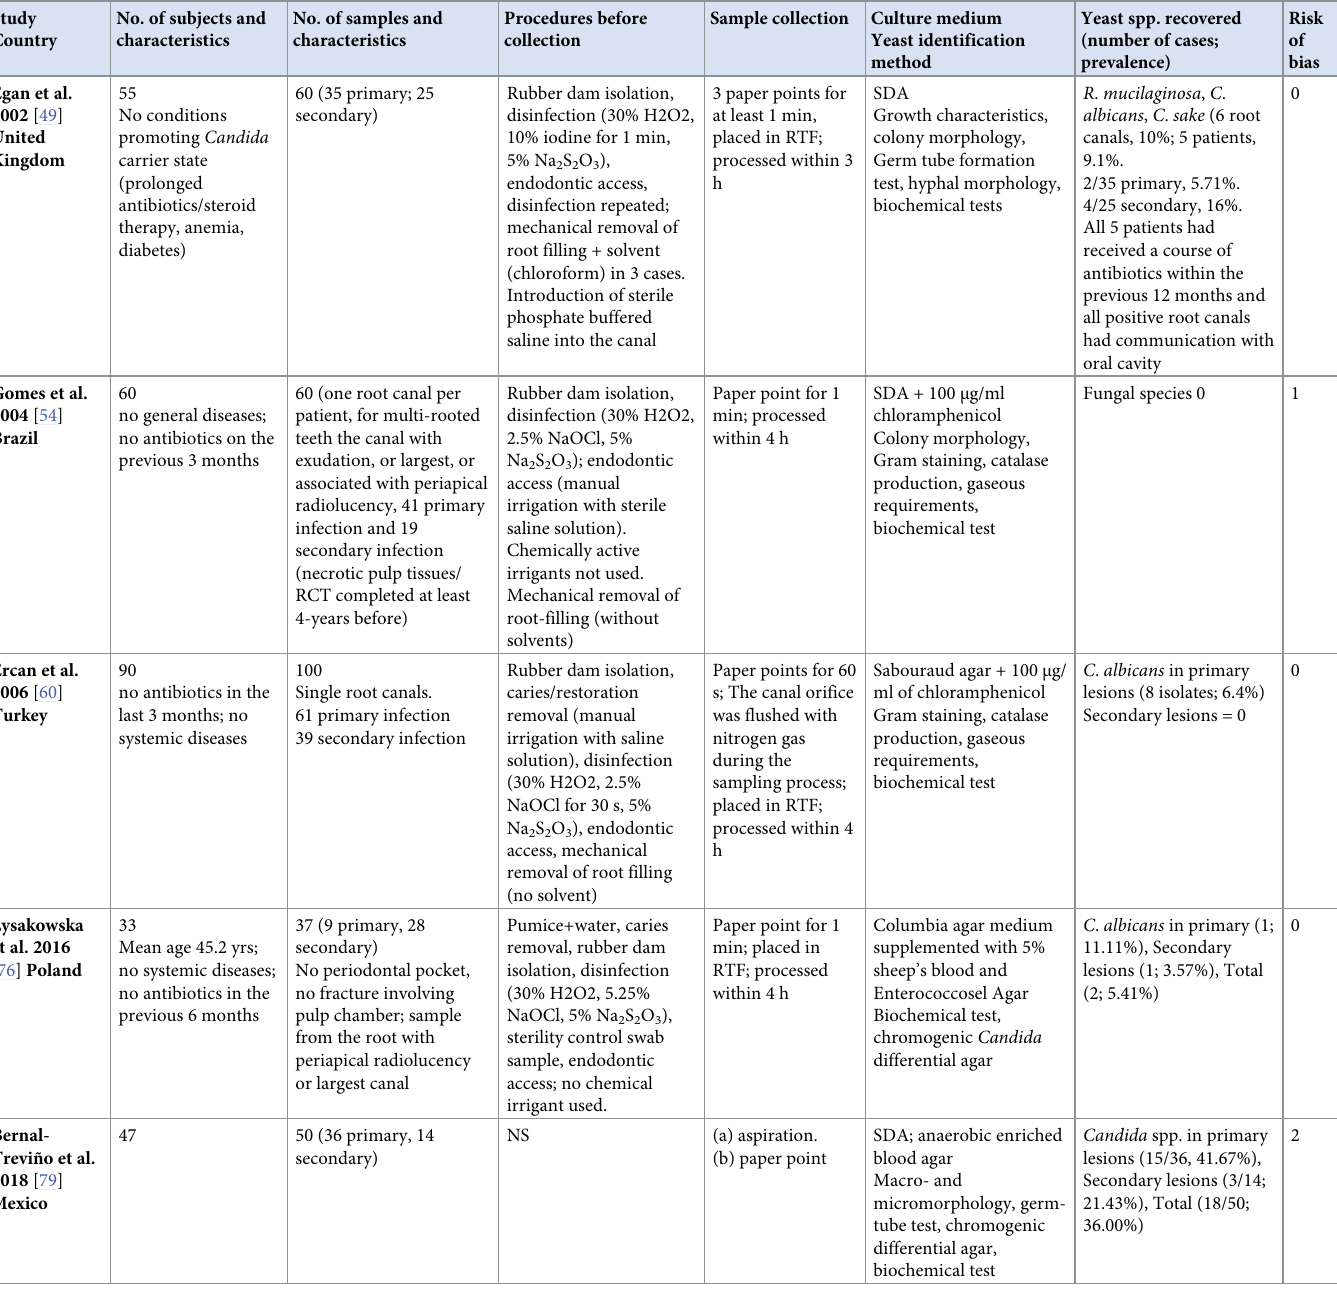
Table 3. Characteristics of the included studies assessing prevalence of yeasts in teeth with primary and secondary endodontic infection using culture methods. Study